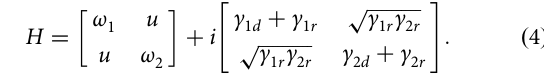
NATURE COMMUNICATIONS| (2022) 13:2103